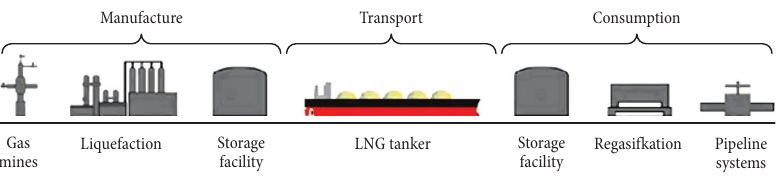
Fig. 1. LNG supply chain (NatGas.info